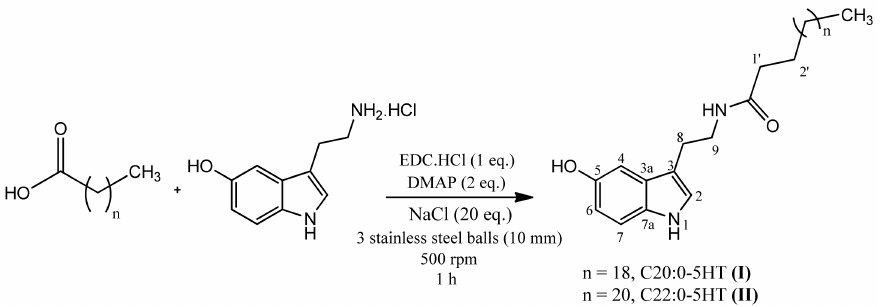
Figure 1. Synthesis of β N -acylserotonins. ( I ) β N -arachinoyl-5-hydroxytryptamide (C 20:0 -5HT); ( II ) β N -behenoyl-5-hydroxytryptamide (C 22:0